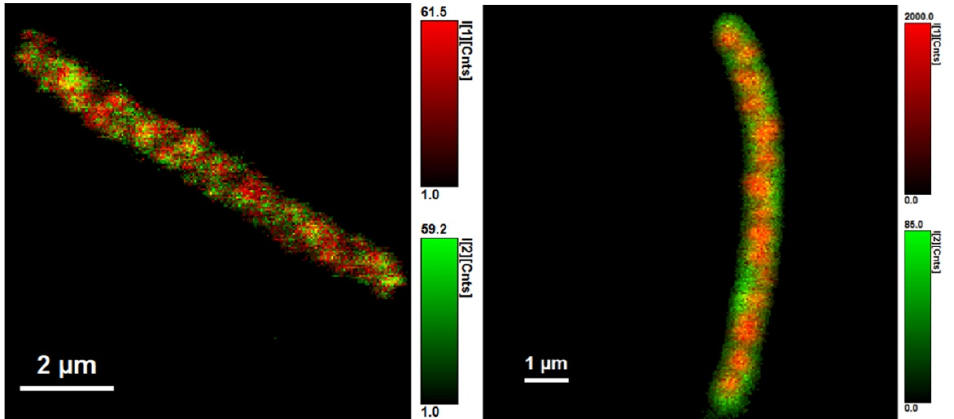
Figure 9. The fluorescence average lifetime of 0.8–1.2 ns can be used as a stable marker (not only of viability) in various biotechnological processes that use fluorophores with average fluorescence lifetime longer than 4.2 ns.